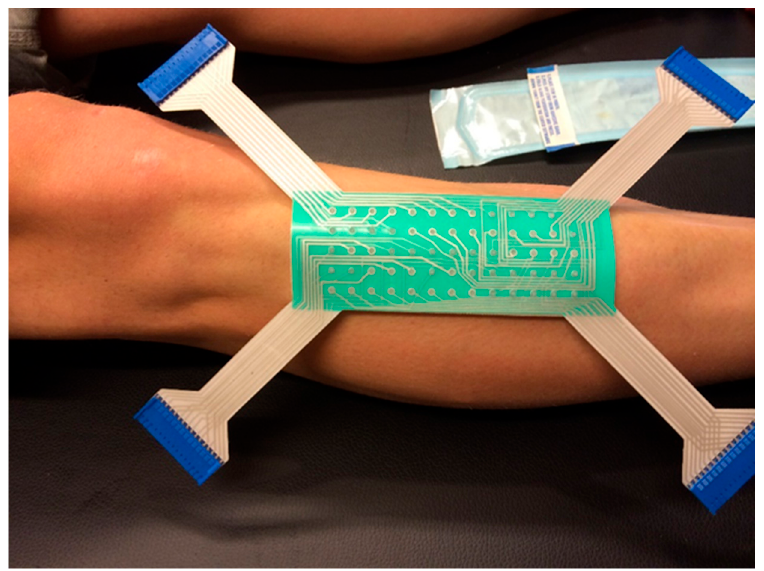
Figure 3. Placement of the ELSCH064R3 electrode grid; note the missing electrode on the top right corner.